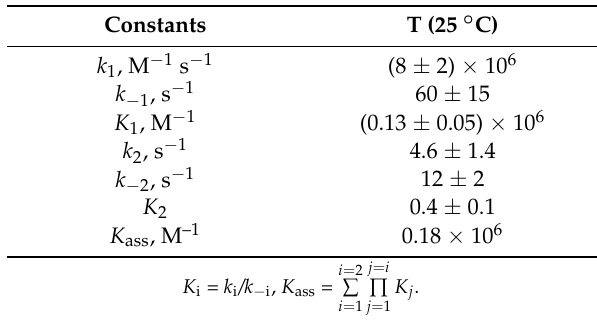
Table 6. Rate and equilibrium constants corresponding to the interaction of Endo III K120A with